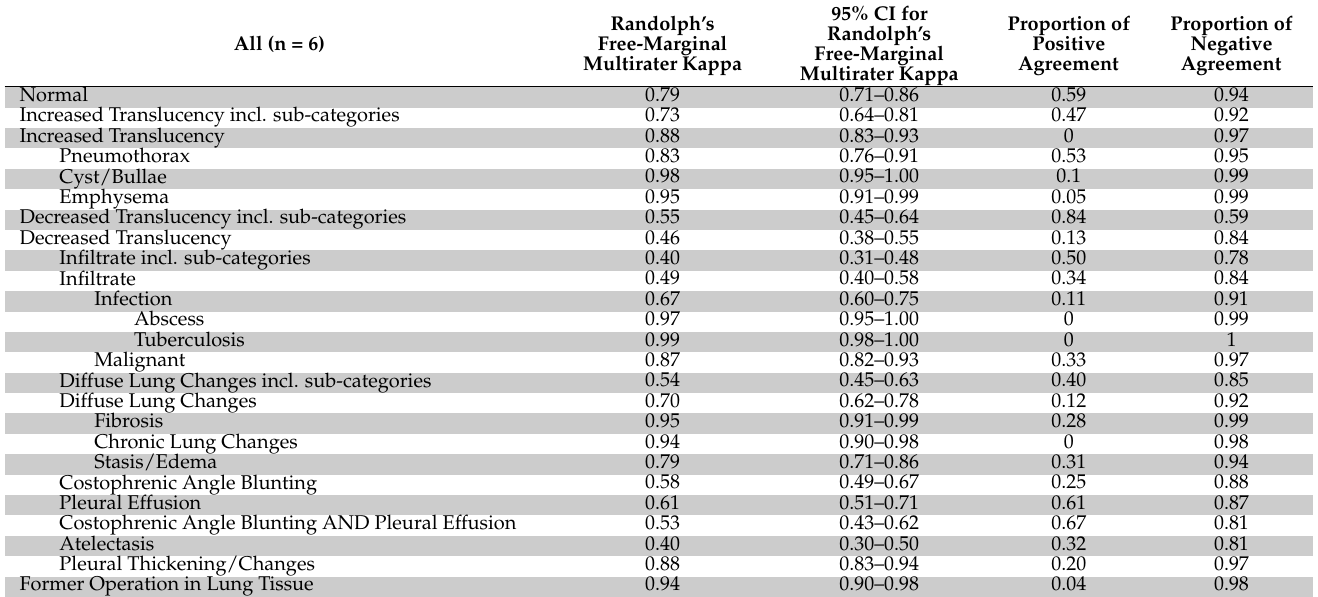
Table 2. Agreement between all readers measured in Randolph’s Kappa, proportion of positive agreement, and proportion of negative agreement. Kappa: <0, poor; 0.01–0.20, slight; 0.21–0.40,